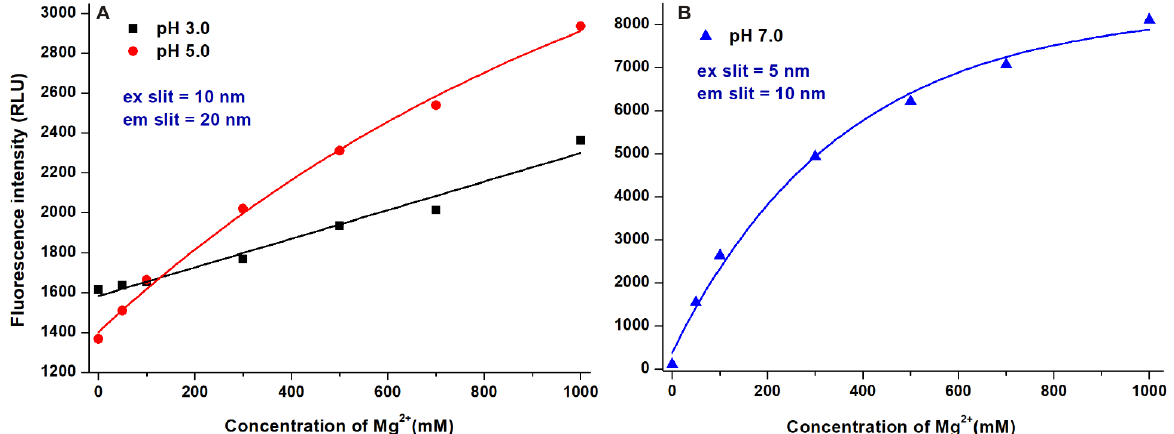
Figure 6. Effects of increasing Mg 2+ concentrations on the fluorescence emission signal of AOH (5 µ M) in sodium phosphate ( A ; 50 mM, pH 3.0; ex slit: 10 nm, em slit: 20 nm), sodium acetate ( A ; 50 mM, pH 5.0; ex slit: 10 nm, em slit: 20 nm), and Tris-HCl ( B ; 50 mM, pH 7.0; ex slit: 5 nm, em slit: 10 nm) buffers ( λ ex = 345 nm, λ em = 440 nm; RLU: relative light unit). Table 2. Binding constants ( K ) of AOH-cation complexes based on modeling studies.